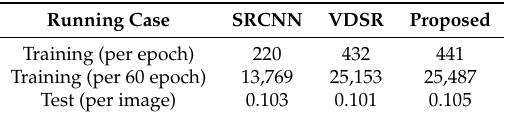
Table 3. Comparison of training and testing running times (sec) for SRCNN [1], VDSR [2], and the proposed method.